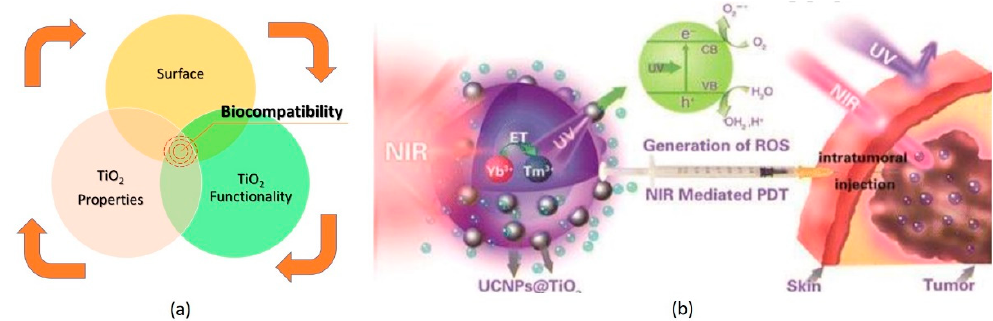
Figure 10. Biocompatibility of TiO 2 NPs ( a ) and antitumor treatment by TiO 2 NP ROS formation ( b ). Adapted with permission from [147]. Copyright, 2015 American Chemical Society.